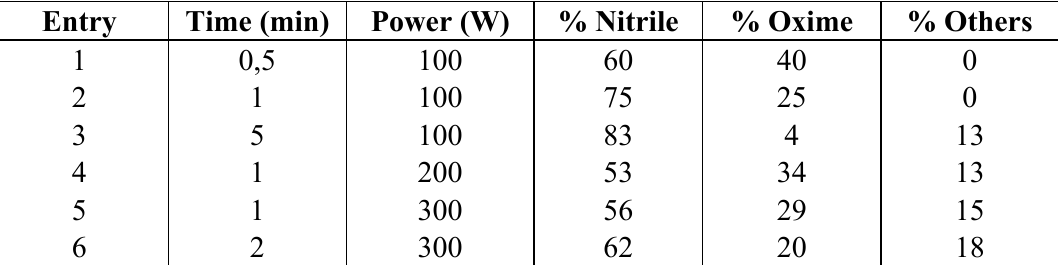
Table 1. Time and Potency Effects on the Conversion of Vanillin into Vanillonitrile and Vanillin